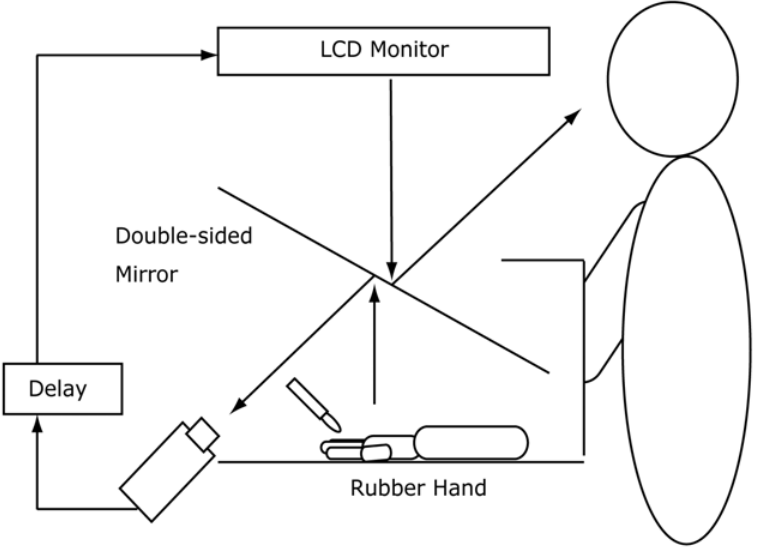
Figure 1. The experimental set-up. The subject watched a delayed image of the rubber hand that was touched synchronously with the subject’s own hand. The length of the visual feedback delay ranged from 100 to 600 ms at 100 ms intervals.